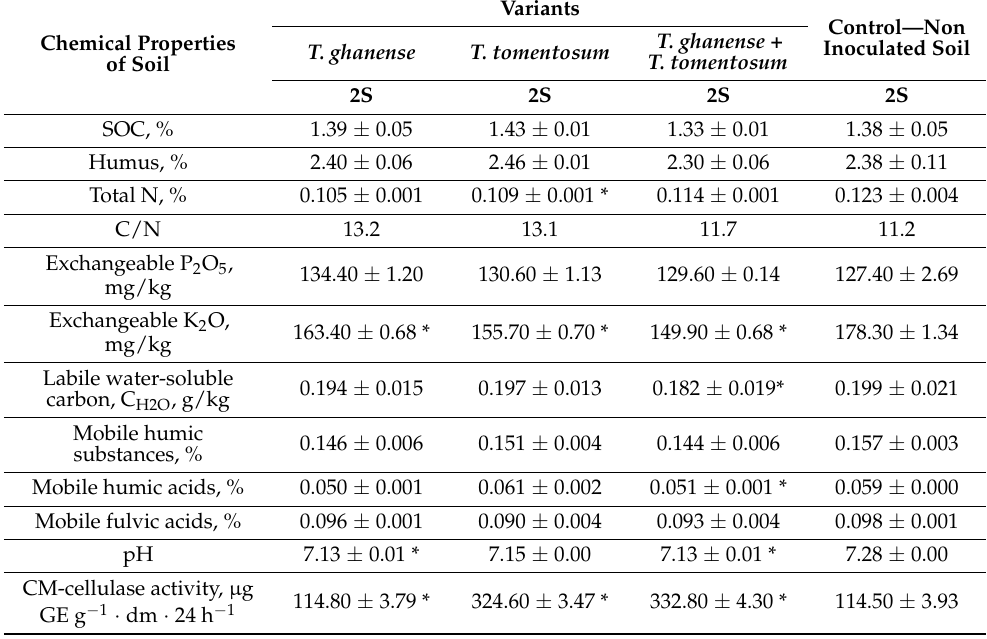
Table 6. The chemical properties of arable soil 2S after 14 days of inoculation. Numbers followed by “*” indicate significant differences ( p <